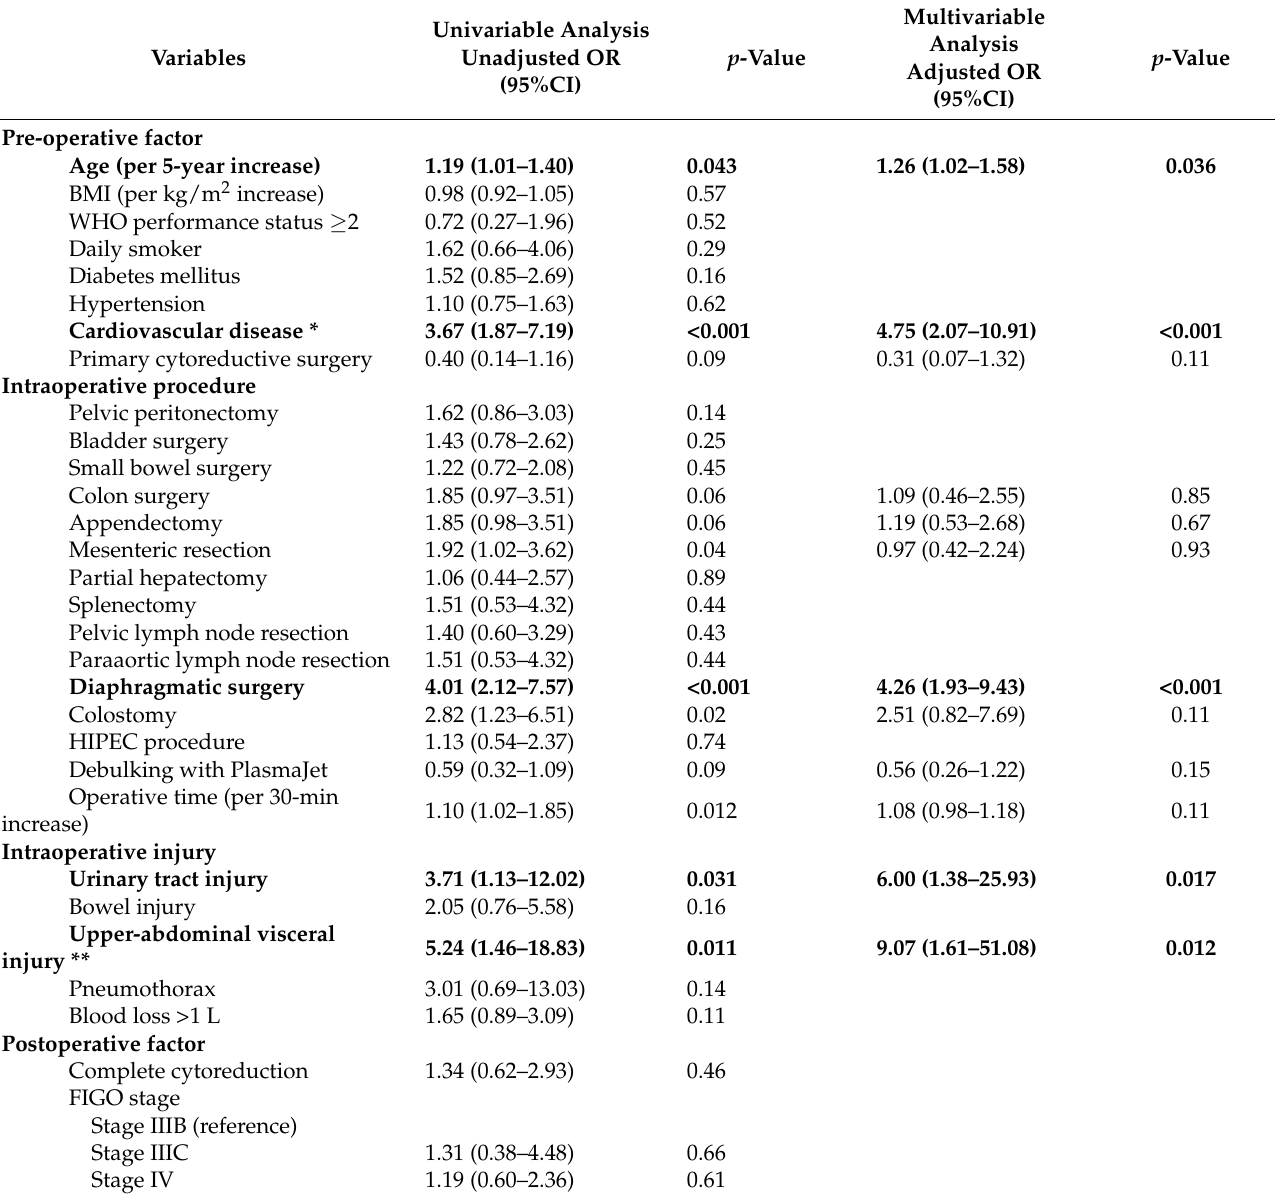
Table 3. Factors related to Clavien–Dindo classification grade ≥ IIIa